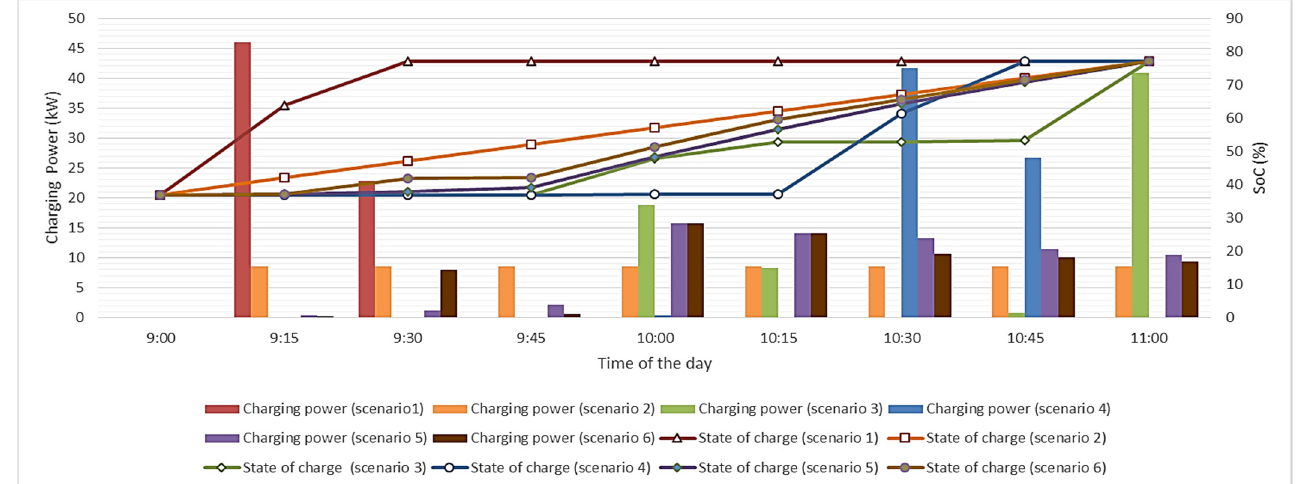
Figure 14. SoC and charging power trajectories for the 250th EV (EV CS = 145) being plugged into a DC charger.